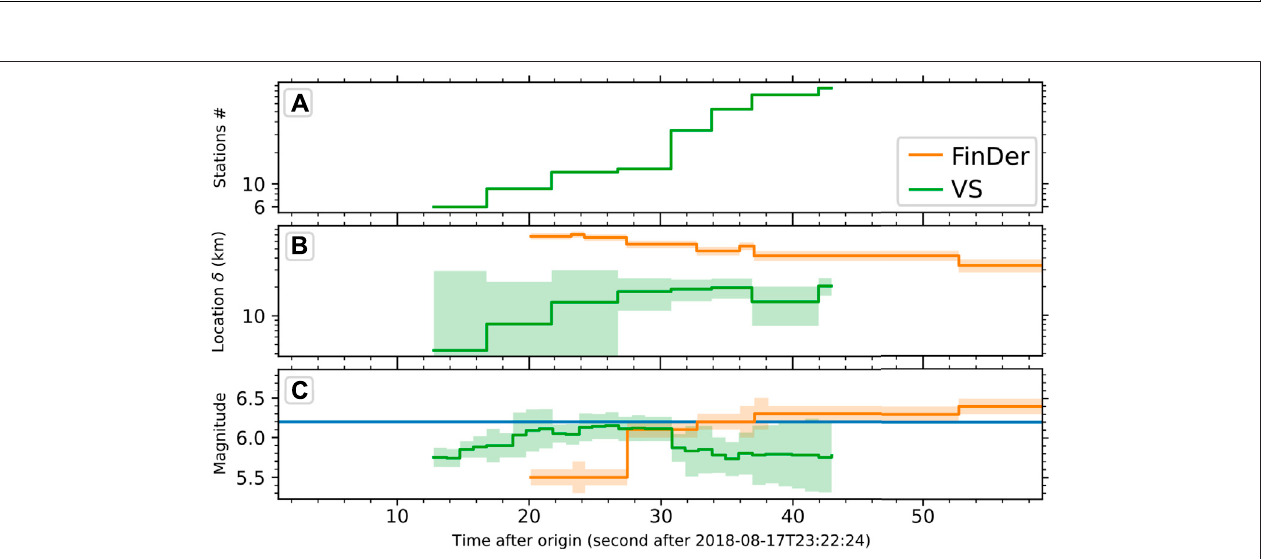
FIGURE 4 | Time evolution of the (A) number of stations contributing to the location, (B) the location error (km), and (C) EEW magnitude for the 2018 Gol fi to earthquake (Mw 6.1).